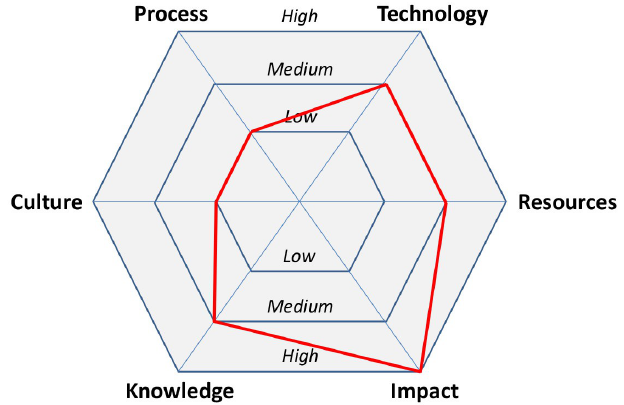
Figure 6. Application of health check tool to projects from case study